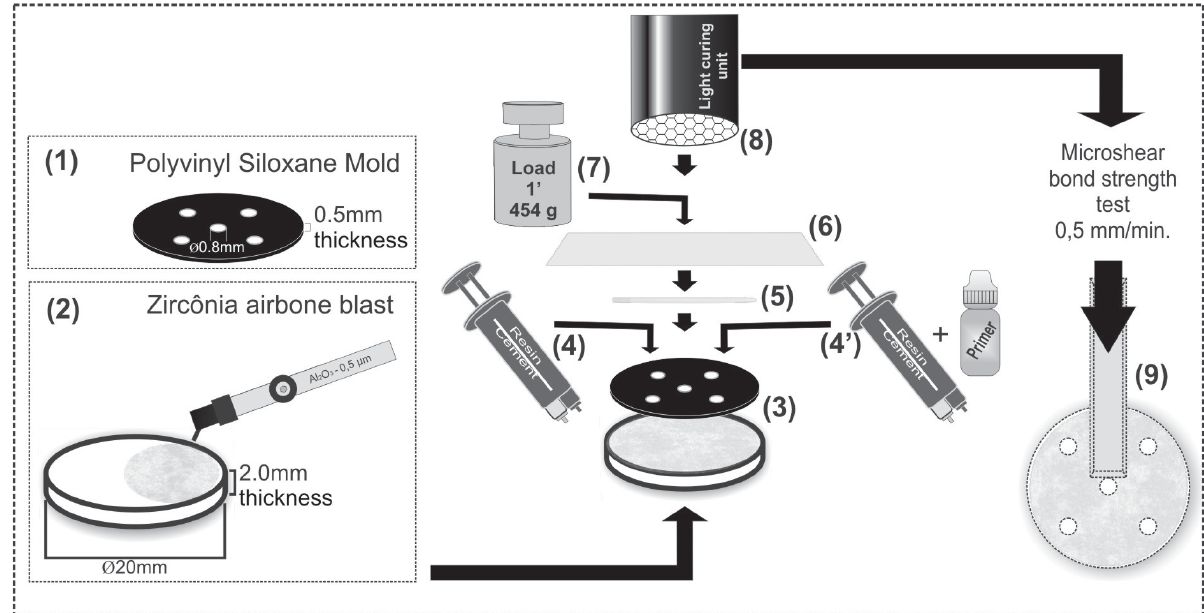
Fig. 1. Experimental set-up for the µ sbs test: (1) Polyvinyl siloxane mold and (2) Al mold with cylinder-shaped orifices positioned over the zirconia surface (4) and filled with luting agent without ceramic primer or (4’) with previous application of ceramic primer. (5) Polyester strip placed between the mold and the glass slab (6). (7) Cementation load (454 gF) applied for one minute. (8) Photoactivation (20 s) of the resin cement through the glass slab for each orifice. (9) Microshear bond strength